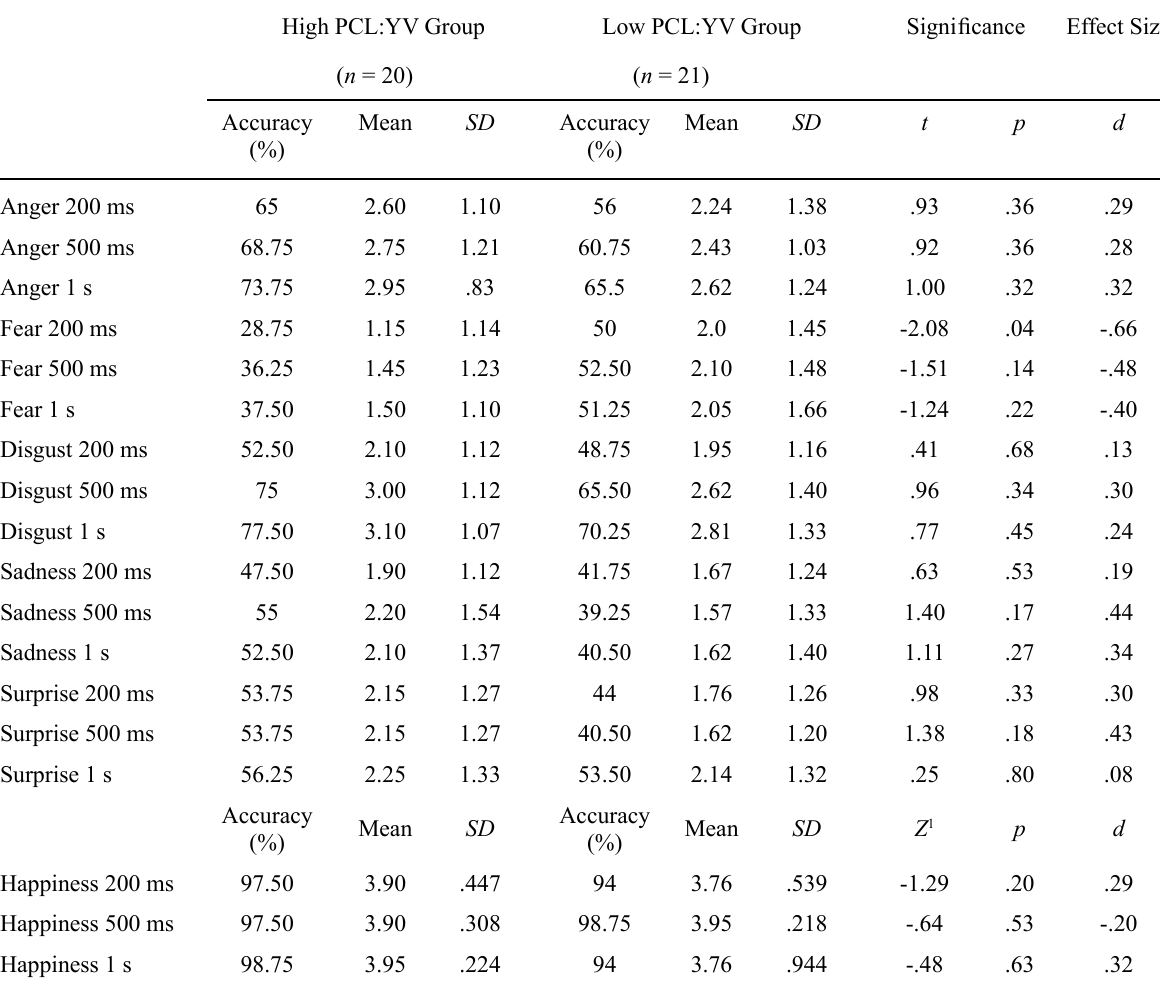
Table 1 Recognition of Facial Affect Accuracy for Youth High in Psychopathic Traits and for Youth Low in Psychopathic Traits High PCL:YV Group Low PCL:YV Group Signi fi cance Effect